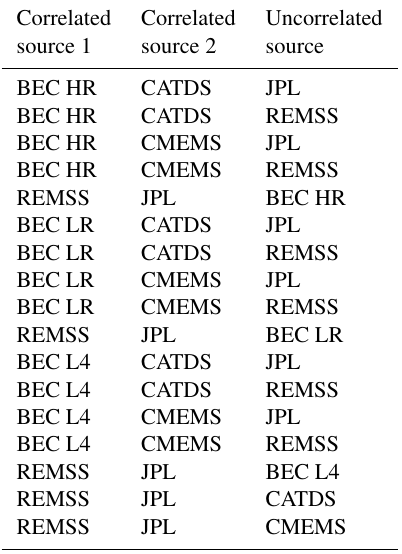
Table 1. SSS triplets used in the analysis performed in Sect. 3.3.4. Correlated Correlated